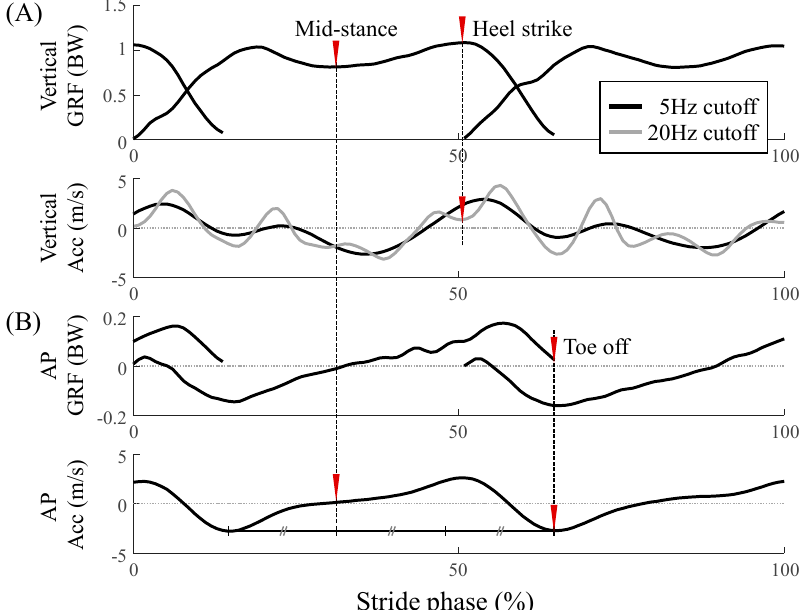
Figure 3. The average acceleration data from IMU during the stride phase for all walking speeds of all 17 participants. The averages and the standard deviations of the acceleration in the global frame are represented by black thick and thin solid lines, respectively, and the average and standard deviations of the acceleration in the local frame are represented by a white thick solid line and gray shade area, respectively. The percent of normalized root-mean-square errors (NRMSEs) of the acceleration in the local frame are 9.5 ± 3.3% in x -axis, 8.0 ± 3.5% in y -axis, and 2.3 ± 0.7% in z -axis.